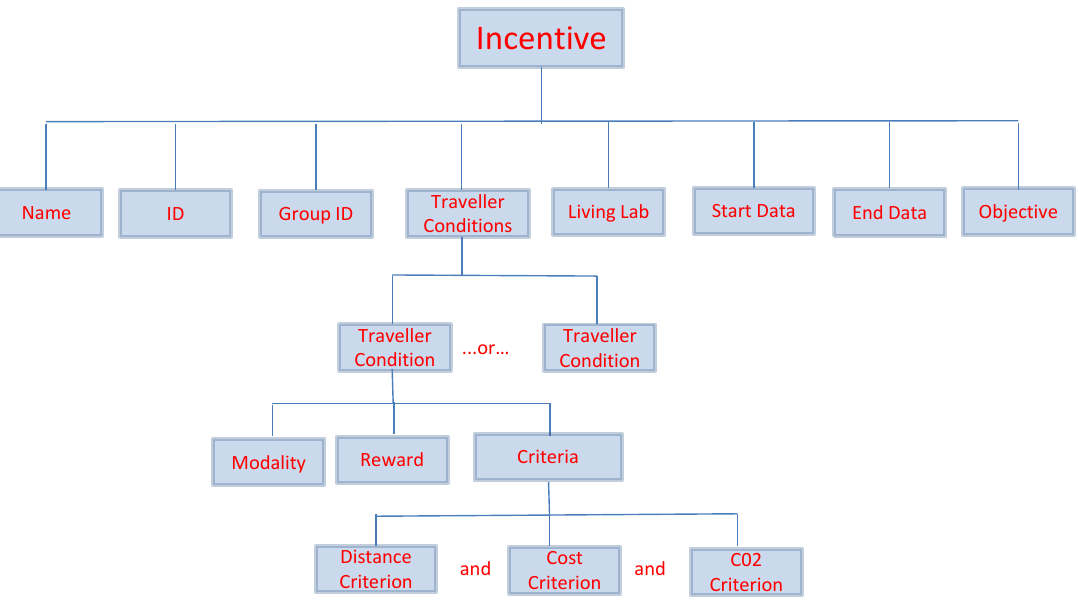
Figure 5. Structure of a “Target and Challenge”